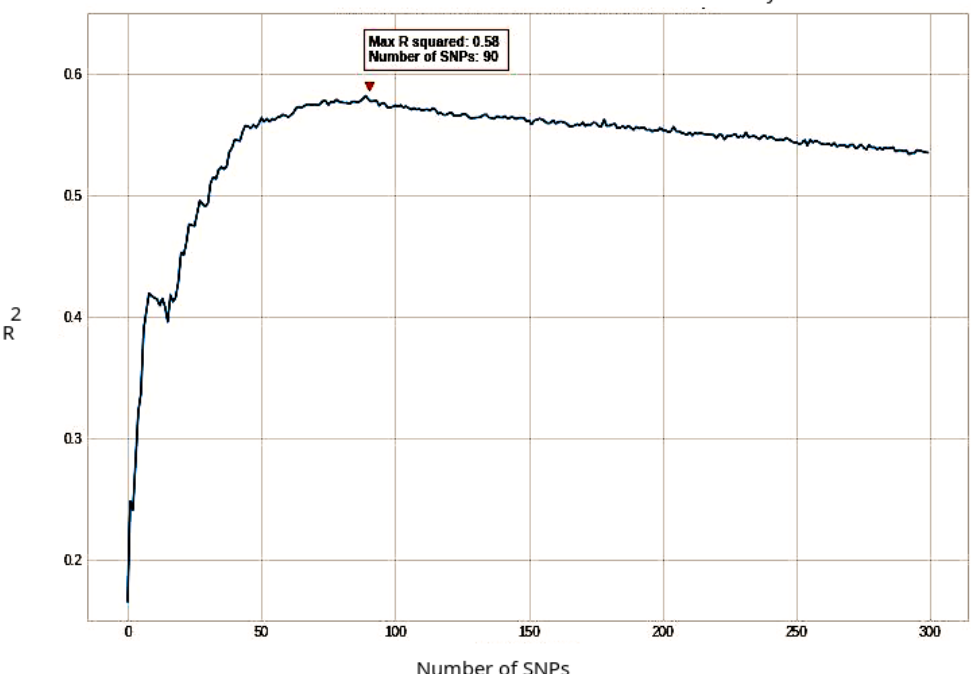
Figure 2. A plot to show the change of R 2 − values versus the number of rSNPs in association with the phenotype pollen shed. The incremental feature selection (IFS) curves were drawn using the ranking of rSNPs. The R 2 − value reached a peak when considering the first 90 rSNPs. These rSNPs were used for the further analysis of this